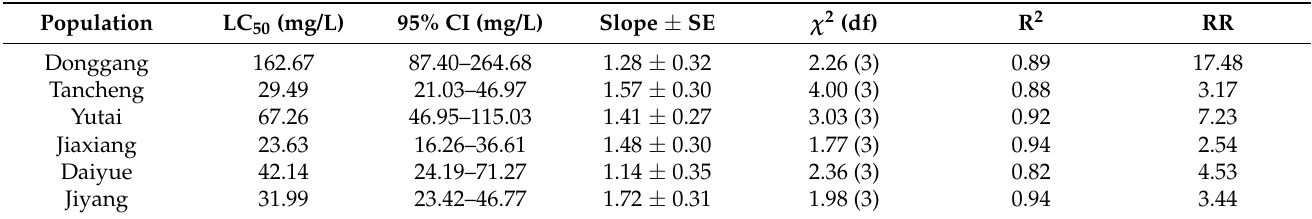
Table 3. Sensitivity to imidacloprid in six L. striatellus populations in Shandong Province.